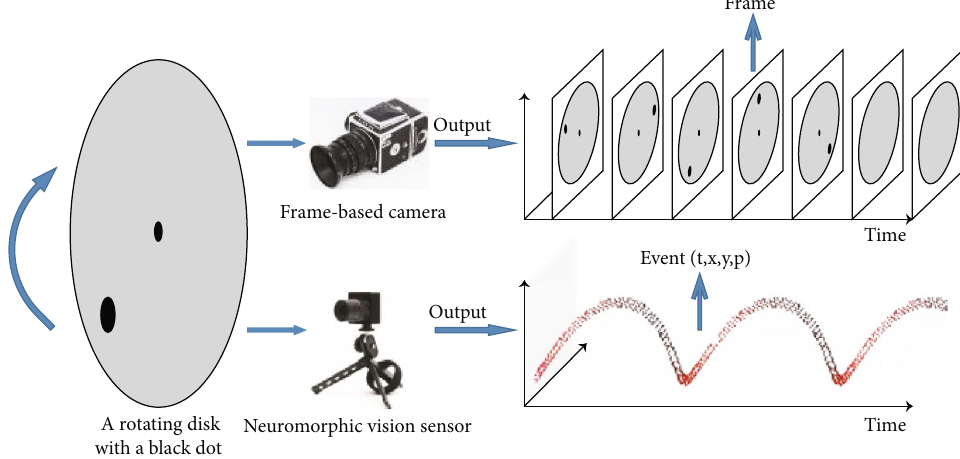
Figure 1: Comparison of the output of a standard frame-based and an event-based sensor when facing a rotating disk with a black dot. The standard camera outputs frames at a fi xed rate, thus sending redundant information when no motion is present in the scene. Standard cameras also su ff er from motion blur during rapid motion and lost all the information between two adjacent frames. Event-based sensors instead respond to pixel-level brightness changes with microsecond latency. Therefore, they do not su ff er from motion blur and do not report anything when everything is at rest. This fi gure is cited from [66].